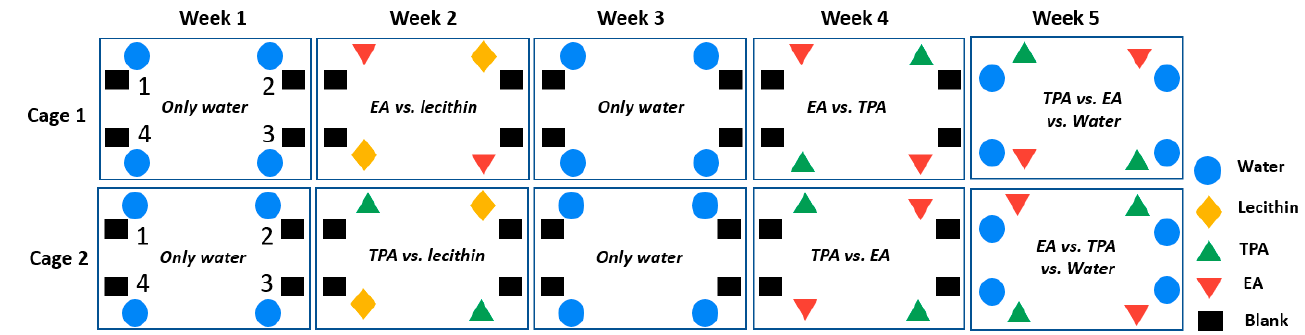
Figure 1. Experimental procedure of animal study during 5 weeks in 2 cages, W: week. Blue circle represents water bottle, yellow diamond represents lecithin vesicles, green triangle represents TPA formulation, red triangle represents EA formulations and black rectangle represents blank bottle for each corner.